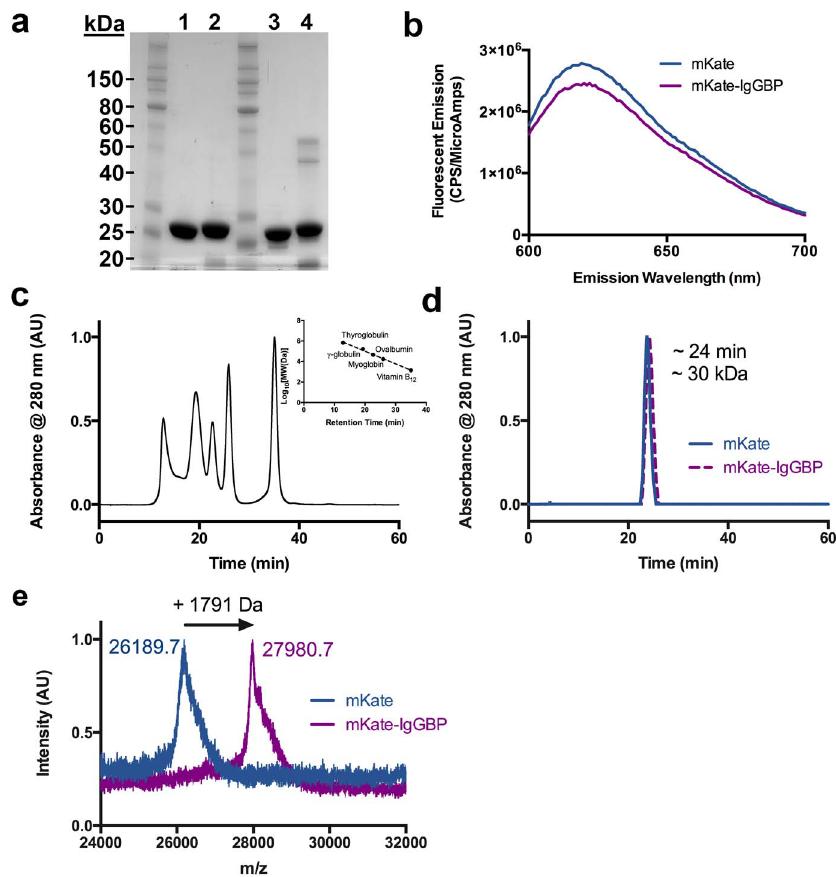
Figure 2. Characterization of mKate and mKate-IgGBP fusion. (a) SDS-PAGE analysis of purified mKate (lanes 1, 3) and mKate-IgGBP (lanes 2, 4) under reducing (lanes 1, 2) and non-reducing conditions (lanes 3, 4). 7.5 ug of protein was loaded in each lane. (b) Fluorescence emission spectra comparing equal molar concentrations (500 nM in D-PBS) of mKate and mKate-IgGBP. (c) Size exclusion chromatography standards and associated standard curve. The standards include thyroglobulin 670 kDa, gamma-globulin 158 kDa, ovalbumin 44 kDa, myoglobin 17 kDa, and vitamin B12 1.35 kDa. (d) Size exclusion chromatogram of mKate and mKate-IgGBP with retention time and calculated molecular weight. (e) MALDI-TOF analysis of mKate and mKate-IgGBP intact mass indicating a shift in molecular weight corresponding to the expected mass of the added flexible linker and IgGBP sequence.